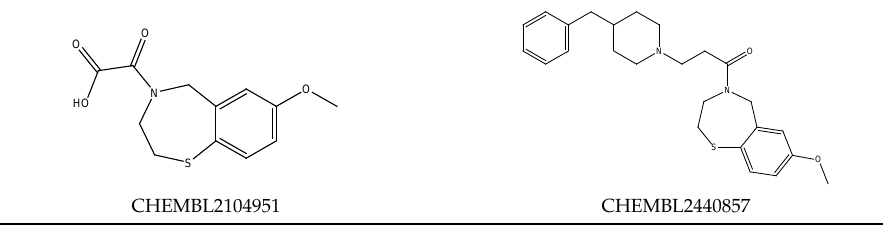
Reaxys RN = 6006308 (Ref. [41]) Figure 1. Estimated types of activity of 1,3,4-thiadiazines. Legend: the graph presents data on the types of biological activity described in the literature for 1,3,4-thiadiazines. The data may be incomplete, since they were obtained on the basis of a search query from December 2016 (1,3,4-thiadiazines AND [1,3,4]thiadiazines) in Scopus/Web of Science/Pubmed. 272 papers were found on these compounds, of which the presence/absence of biological effects was described in 132. The patents were not included in the search.